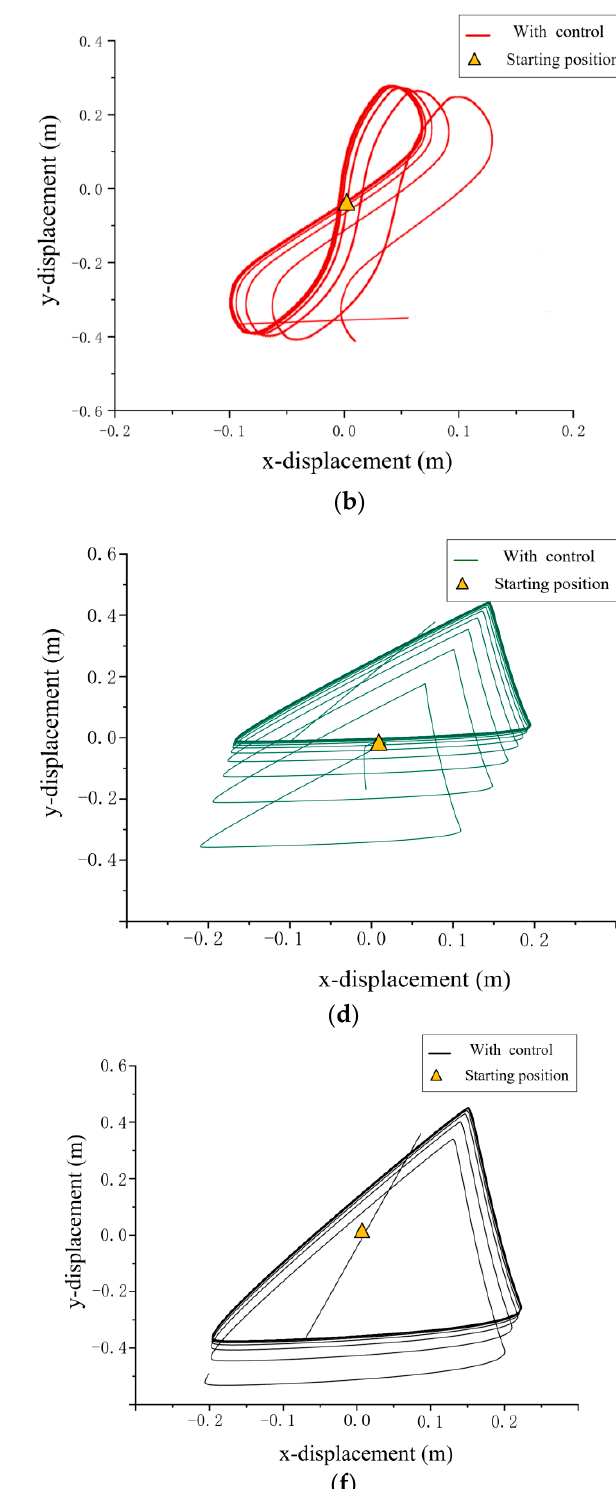
Figure 11. The dynamic response of TTAS under Condition 1. ( a ) The x, y displacement without control of the payload when the hoist cable is 0.6 m; ( b ) the x, y displacement with control of the payload when the hoist cable is 0.6 m; ( c ) the x, y displacement without control of the payload when the hoist cable is 1.2 m; ( d ) the x, y displacement with control of the payload when the hoist cable is 1.2 m; ( e ) the x, y displacement without control of the payload when the hoist cable is 1.8 m; ( f ) the x, y displacement with control of the payload when the hoist cable is 1.8 m.